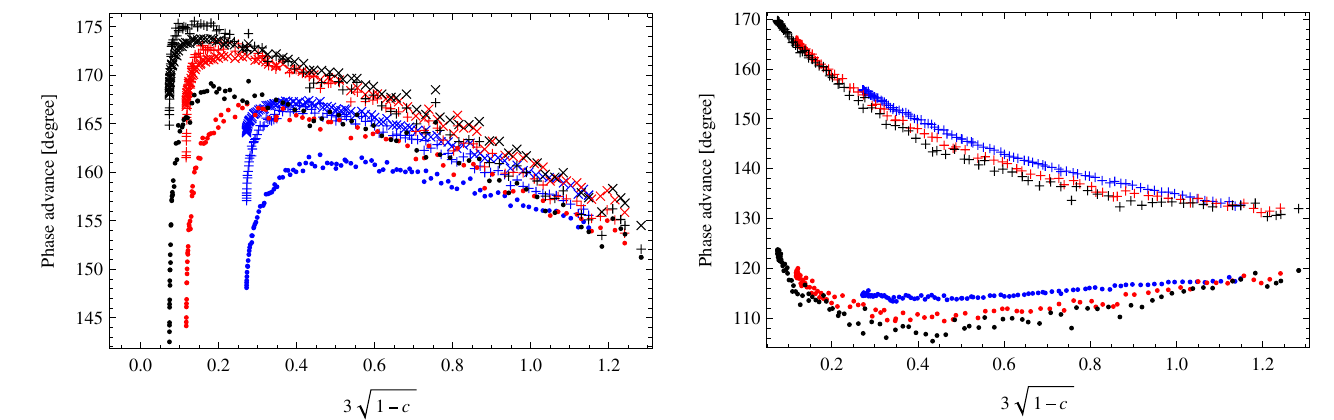
FIG. 10. Phase advances in the straight section for TME ( þ ), and EME ( (cid:7) ) under different peak fields 2 (blue), 4 (red), and 6 (black). Phase advances for uniform dipoles are 133 (cid:6) and 115 (cid:6) , respectively.